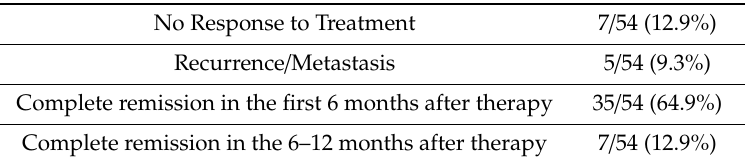
Table 1. Patients’ response to